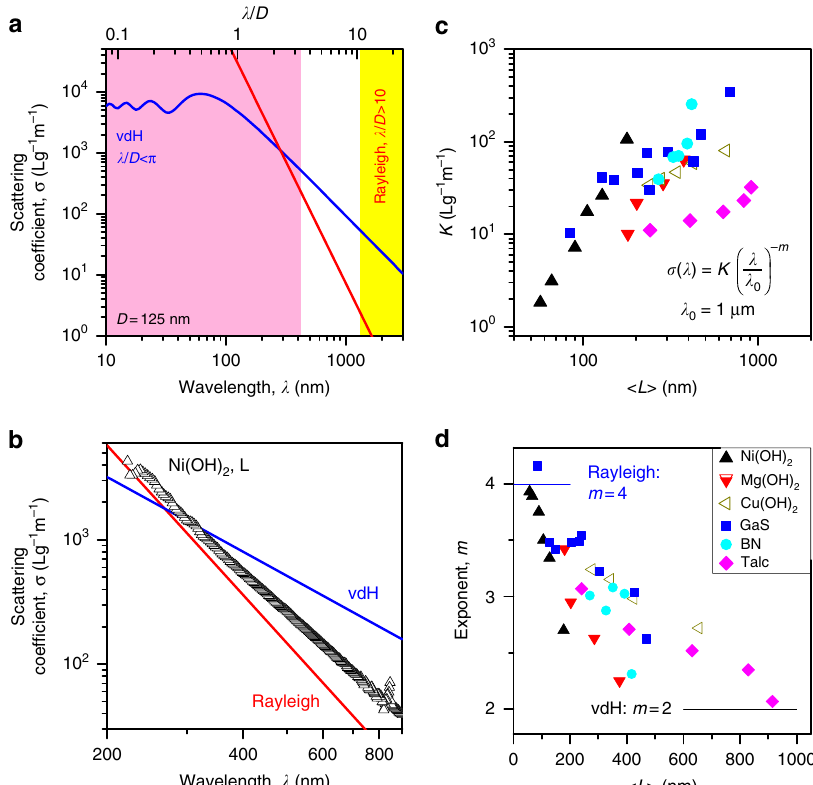
Fig. 6 Light scattering in the non-resonant regime. a Theoretical scattering coef fi cients plotted versus wavelength (bottom axis) and λ / D (top axis). The blue and red lines represents the van de Hulst and Rayleigh approximations for spheres ( D = 125 nm) with n = 1.76, ρ = 4100 kg/m 3 (appropriate for Ni (OH) 2 ). The pink and yellow fi elds show the approximate ranges where we expect the vdH and Rayleigh approximations to be accurate. b Measured scattering coef fi cients plotted versus wavelength for the Ni(OH) 2 :L sample ( 〈 L 〉 = 128 nm) with the approximations mentioned above plotted for comparison (taking D = 〈 L 〉 = 128 nm). c Scattering parameter, K , plotted versus 〈 L 〉 for all samples (de fi ned via σ = K [ λ / μ m] − m ). (N.B.: When de fi ned in this way, K represents the scattering coef fi cient at λ = 1 μ m.) d Scattering exponent, m, plotted versus mean nanosheet length. The solid lines show the values expected from the Rayleigh and vdH approximations. The legend in d also applies to